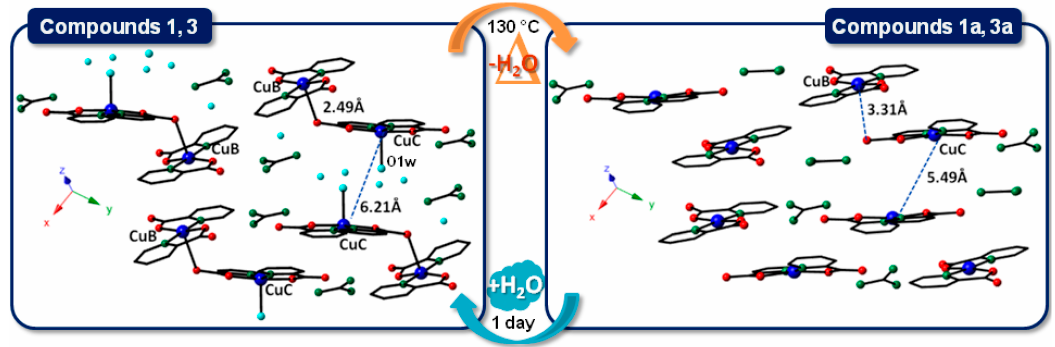
Figure 8. Arrangement of {Cu(pic) 2 } fragments and [C(NH 2 ) 3 ] + cations in the metalorganic region of 1 and 3 compared to that found in the anhydrous phases 1a and 3a .